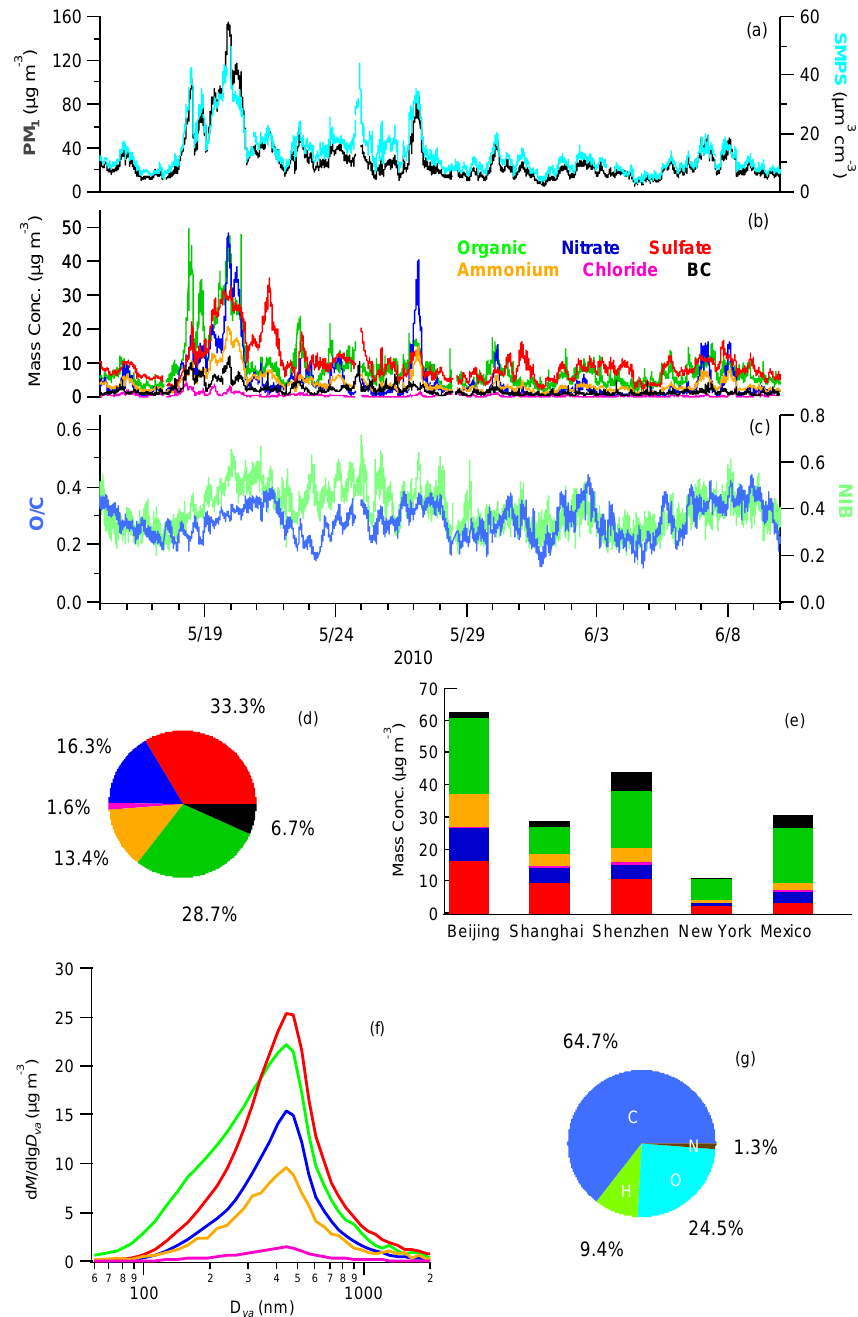
Fig. 1. The time series of (a) PM 1 mass concentration by AMS species+BC and SMPS volume; (b) PM 1 species concentrations; (c) O/C ratio of OM and number fraction of internally mixed BC (NIB); (d) the average PM 1 composition; (e) the comparison of PM 1 composition with other mega-cities; (f) the mean species size distributions; and (g) the average mass-based organic elemental